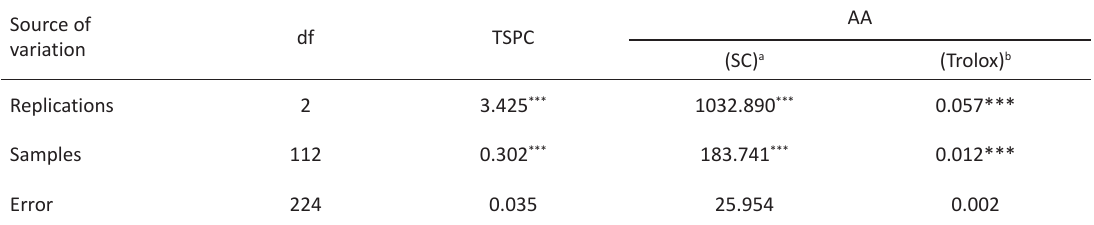
Table 3. Mean squares of soluble phenolic compounds (TSPC) and antioxidant activity (AA) of a tetraploid wheat collection grown at Valenzano (Bari, Italy) in 2010. AA Source of df TSPC variation (SC) a (Trolox) b Replications 2 3.425 *** 1032.890 *** 0.057*** Samples 112 0.302 *** 183.741 *** 0.012*** Error 0.035 25.954 0.002